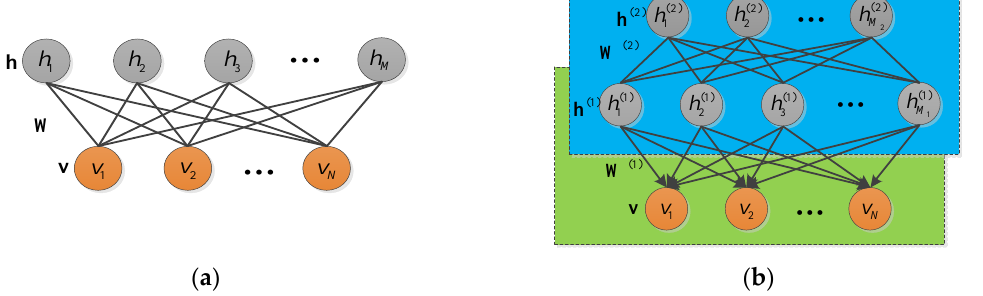
Figure 7 . The model represented by RBM: ( a ) RBM; ( b ) DBN with two hidden layers.